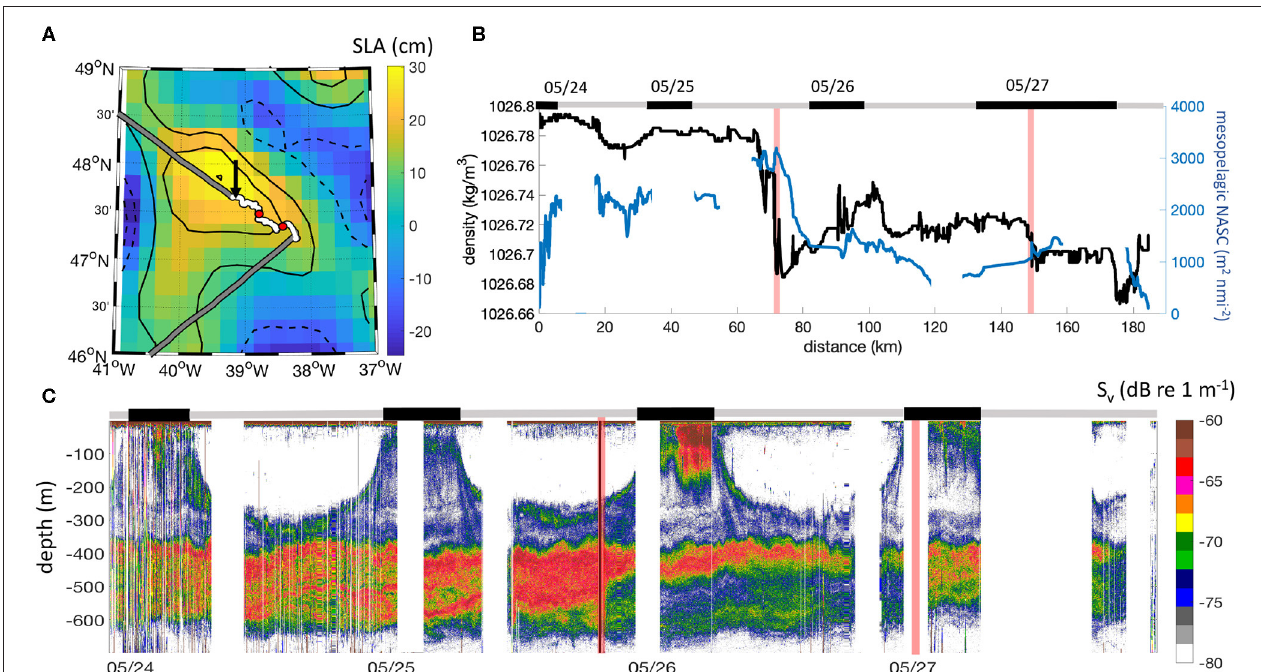
FIGURE 4 | Case study of an anticyclonic eddy sampled in the subtropical northwest Atlantic in May (N2S4). (A) High-pass filtered SLA map overlapped to the R/V Atlantis ship track. The white section of the trajectory corresponds to the acoustic sampling and the black arrow indicates the start of the section. (B) Observations of density (black) and mesopelagic NASC (blue) across the eddy. The distance is calculated from the start of the acoustic sampling. (C) 38 kHz echogram of backscattering strength. Gray and black bands on the top of (B,C) indicate observations collected at night (black) and during the day (gray). Red lines (dots in A ) identify the transitions between eddy core, periphery, and ambient